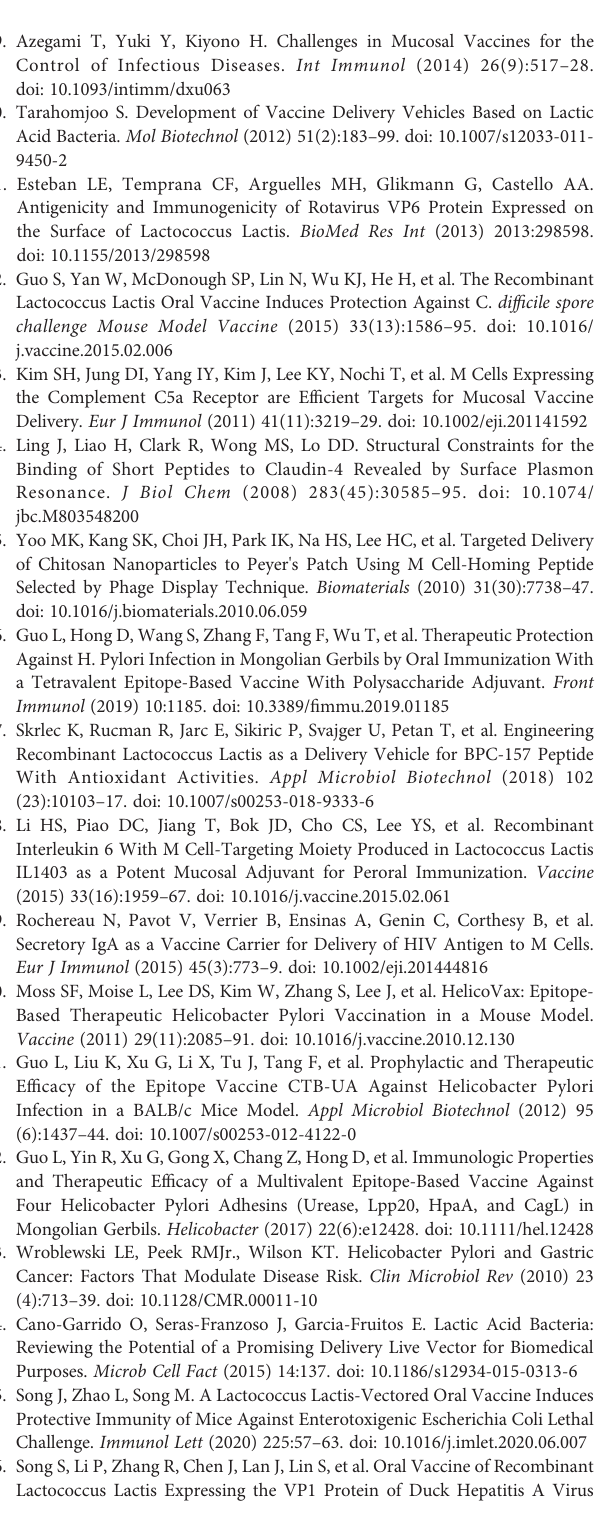
Supplementary Figure 2 | Construction and identi fi cation of the plasmid plSAM- FVpE. (A) The structure of the FVpE vaccine. (B) Construction of the plasmid plSAM-FVpE. (C) Identi fi cation of the plasmid plSAM-FVpE. M: DNA marker; 1: the plasmid plSAM-FVpE. 2: Restriction enzyme digestion of the plasmid